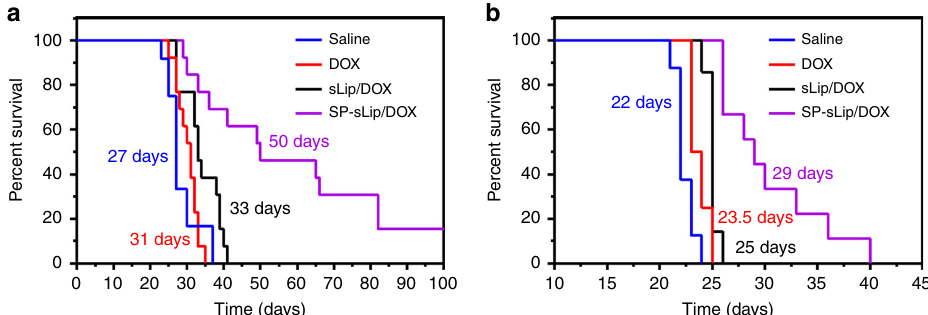
Fig. 6 Kaplan – Meier survival curve of nude mice bearing intracranial brain cancer cells after treatments. For mouse bearing U87 cells ( a ), saline (27 days, n = 12), DOX (31 days, n = 13), sLip/DOX (33 days, n = 13), and SP-sLip/DOX (50 days, n = 13) were intravenously administered at a total DOX dose of 10 mg kg − 1 (injections at day 7, 9, 11, 13, and 15 after U87 cells implantation). For mouse bearing D425 ( b ), saline (22 days, n = 8), DOX (23.5 days, n = 8), sLip/DOX (25 days, n = 7), and SP-sLip/DOX (29 days, n = 9) were intravenously administered at a total DOX dose of 12 mg kg − 1 (injections at day 3, 5, 7, 10, 12, and 14 days after D425 cells implantation). Data were plotted and the median survival time was calculated using GraphPad Prism 6.0 (Log-rank (Mantel – Cox) test)